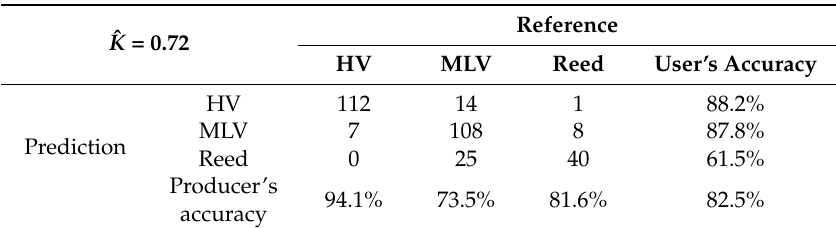
Table 4. Confusion matrix of the RF model using RapidEye (RF model 1). Table 5. Confusion matrix of the RF model using RapidEye and Landsat (1 July) (RF model 2). (cid:2167)(cid:3553) = 0.81 ˆ K =